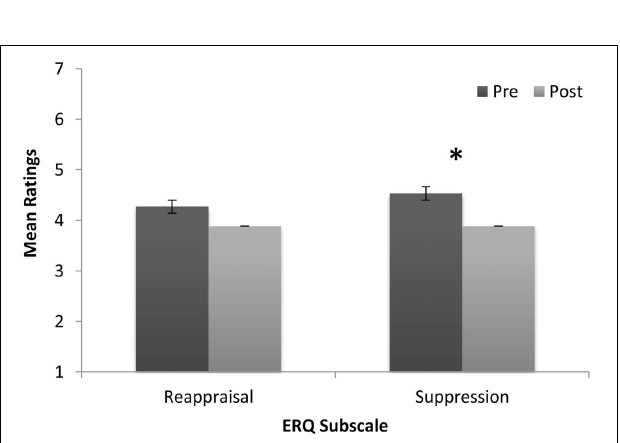
FIGURE 2 | Sample means for 41 at-risk adolescents on the emotion regulation questionnaire cognitive reappraisal and suppression subscales at pre- and post-program. (Bars are standard errors; significance ∗ p <